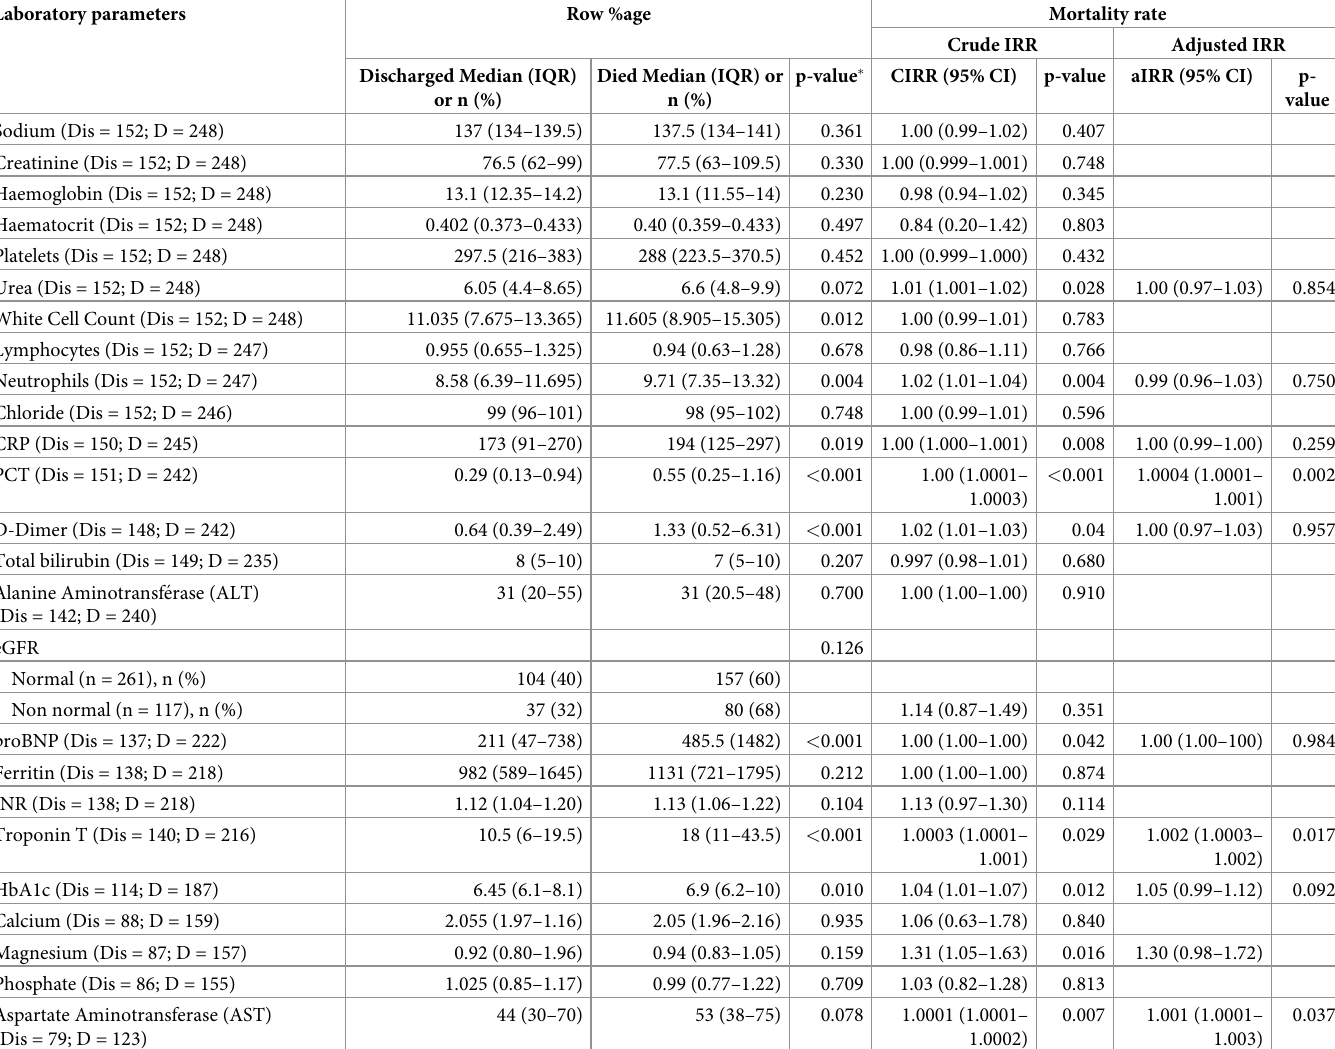
Table 3. Laboratory results at initial measurements associated with mortality among COVID-19 patients admitted to ICU at Tygerberg Hospital. Laboratory